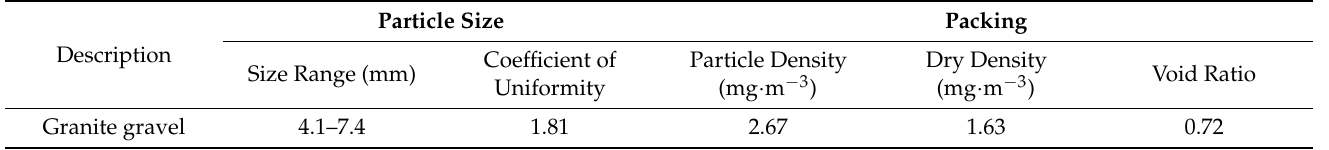
Table 2. Properties of backfill